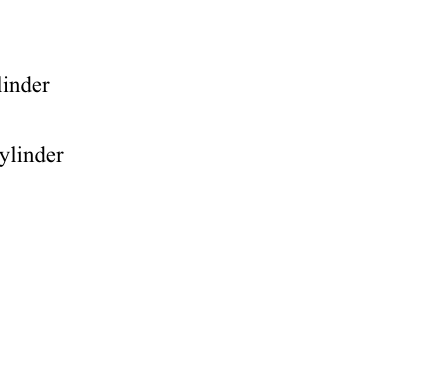
Figure 4. Topology model of mechanical